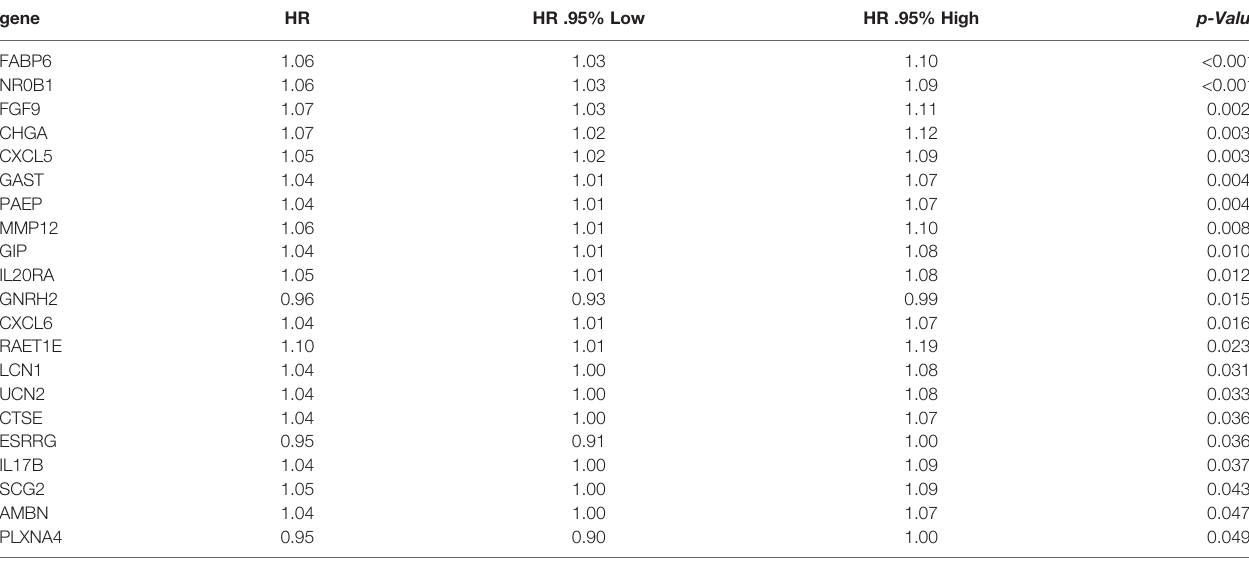
TABLE 1 | The results of univariate Cox regression.